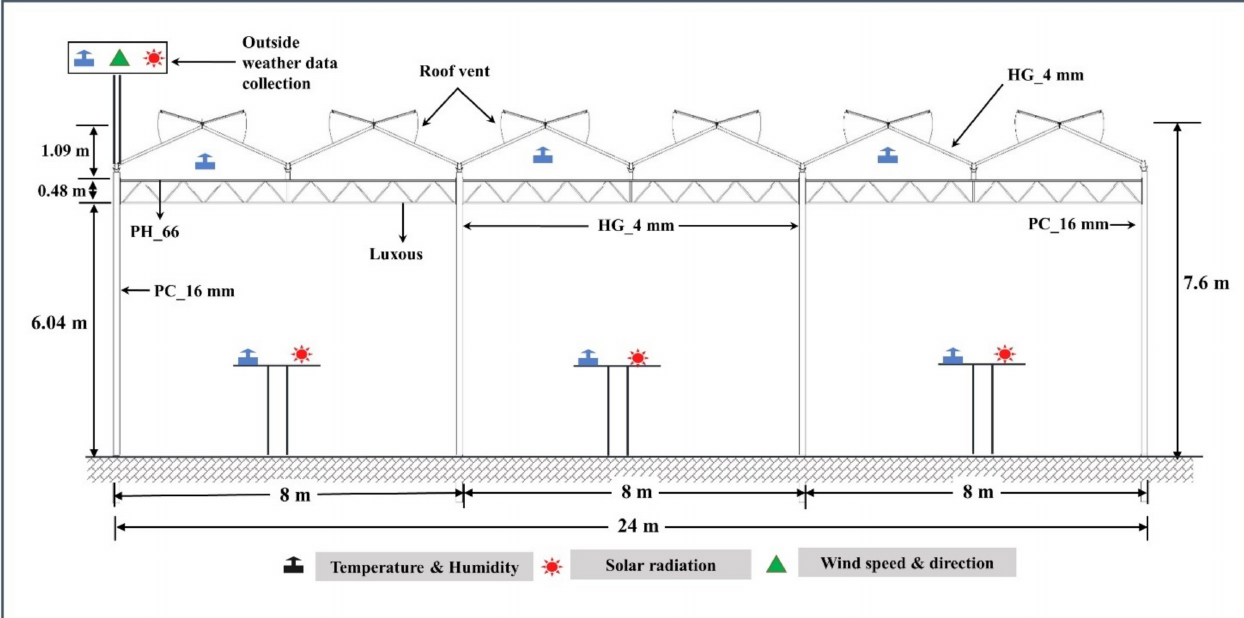
Figure 2. Experimental greenhouse’s dimensions and location of the